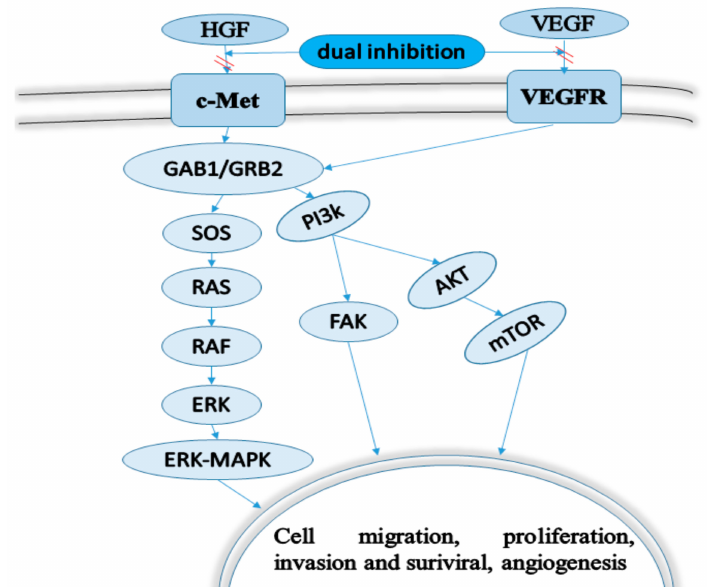
Figure 1. The crosstalk between VEGFR and c-Met (GAB1: GRB2-associated-binding protein 1; GRB2: Growth factor receptor-bound protein 2; SOS: Son of sevenless; RAS: Rat sarcoma viral oncogene homolog; RAF: Root abundant factor; FAK:Focal adhesion kinase; PI3K / AKT: Phosphoinositide 3-kinase / protein kinase B; mTOR:Mammalian target of rapamycin / mechanistic target of